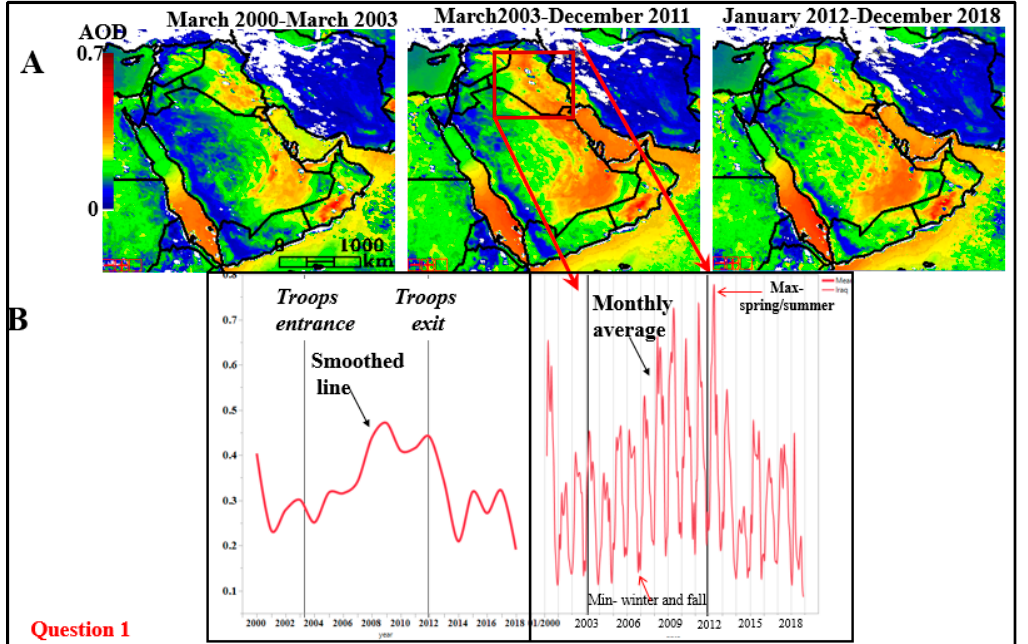
Figure 1. Aerosol optical depth (AOD) spatial and temporal variability over Iraq generated using an open source engine Giovanni (https://giovanni.gsfc.nasa.gov/giovanni/doc/UsersManualworkingdocument.docx.html). ( A ) Averaged AOD on a pixel basis over 1 March 2000–19 March 2003 (before US troop and coalition force entrance), 20 March 2003–31 December 2011 (presence of US and coalition forces), and 1 January 2012– 31 December 2018 (post-war). ( B ) Monthly averaged AOD values over Iraq during 2000–US troop entrance was generally followed by an increase in AOD, whereas the converse is true upon troop